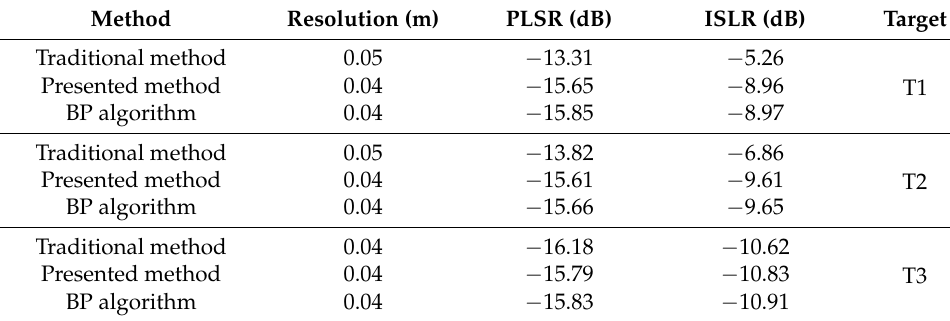
Table 6. Comparison of imaging quality with the wide-bandwidth